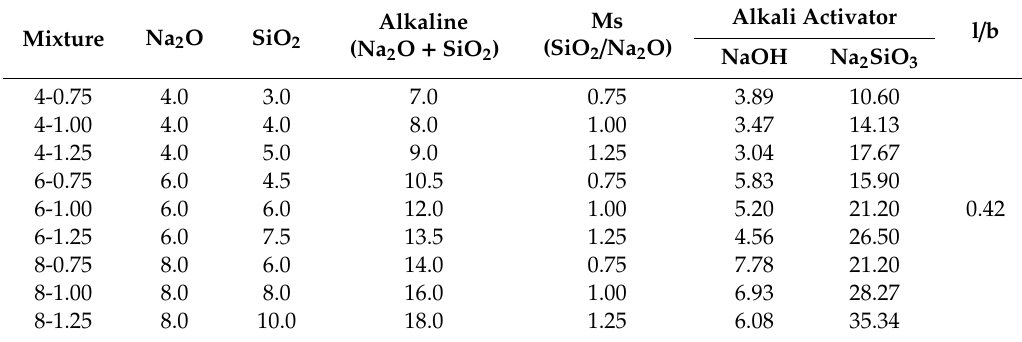
Table 3. Mixture design of alkali-activated slag (AAS) pastes with respect to 100 g of